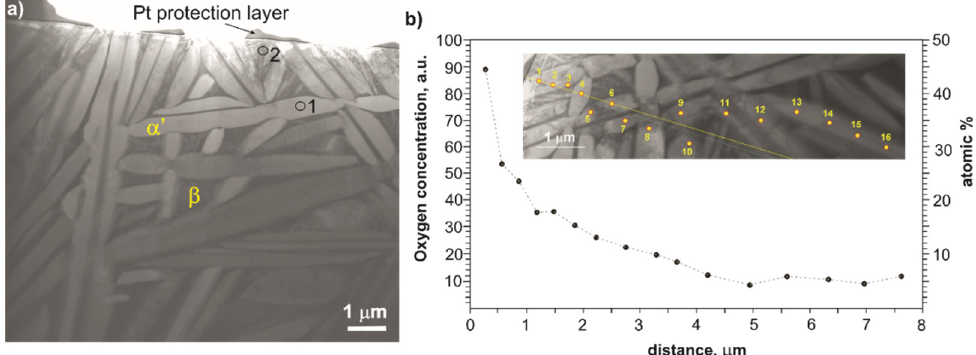
Figure 5. STEM image of the microstructure of the near-surface region in the Ti–13Nb–13Zr alloy cross-section after oxygen hardening at a temperature of 700 ° C ( a ) and concentration profile of oxygen obtained by TEM-EDS microanalysis performed in points 1–16 ( b ). The exemplary grains of the α‘ and β phases, as well as the areas 1 and 2 given in Figure 4, are marked in Figure 5a.